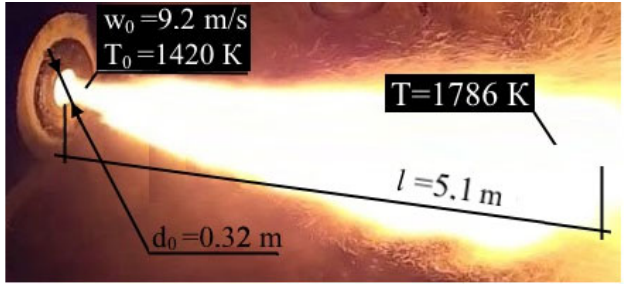
Figure 7. Fuel combustion in a steam generator and the results of the study.